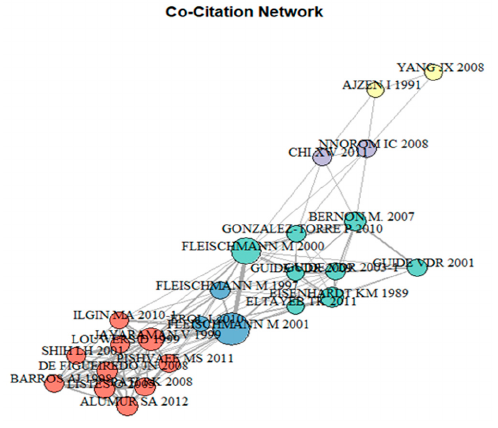
Figure 6. Co-citation network.